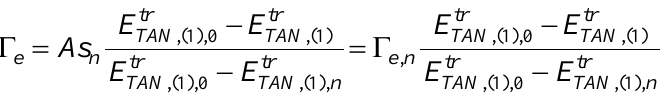
Figure 20. Torque estimation with tr